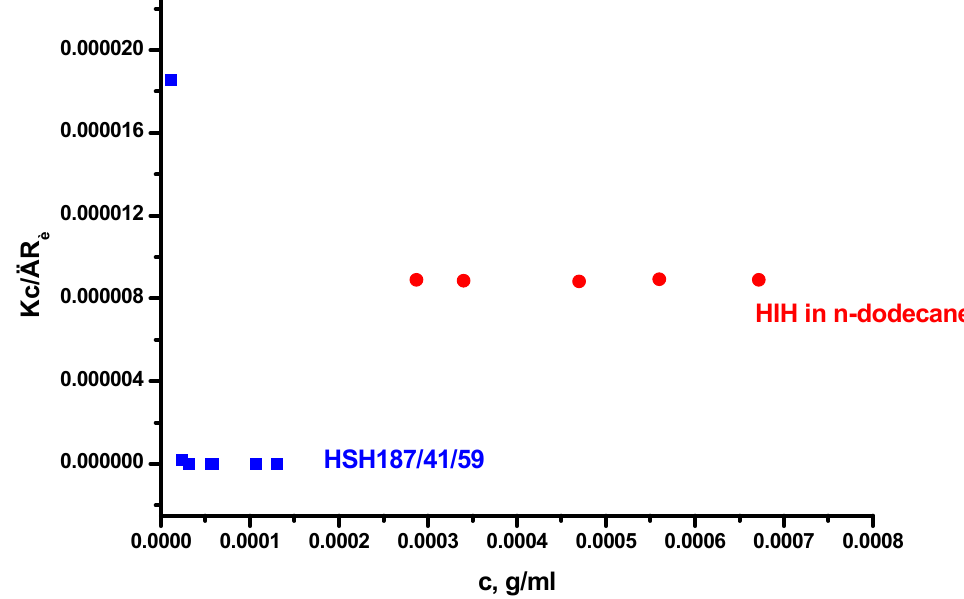
Figure 2. LALLS plots of triblock copolymers HSH#2 in n-heptane and HIH in n-dodecane.